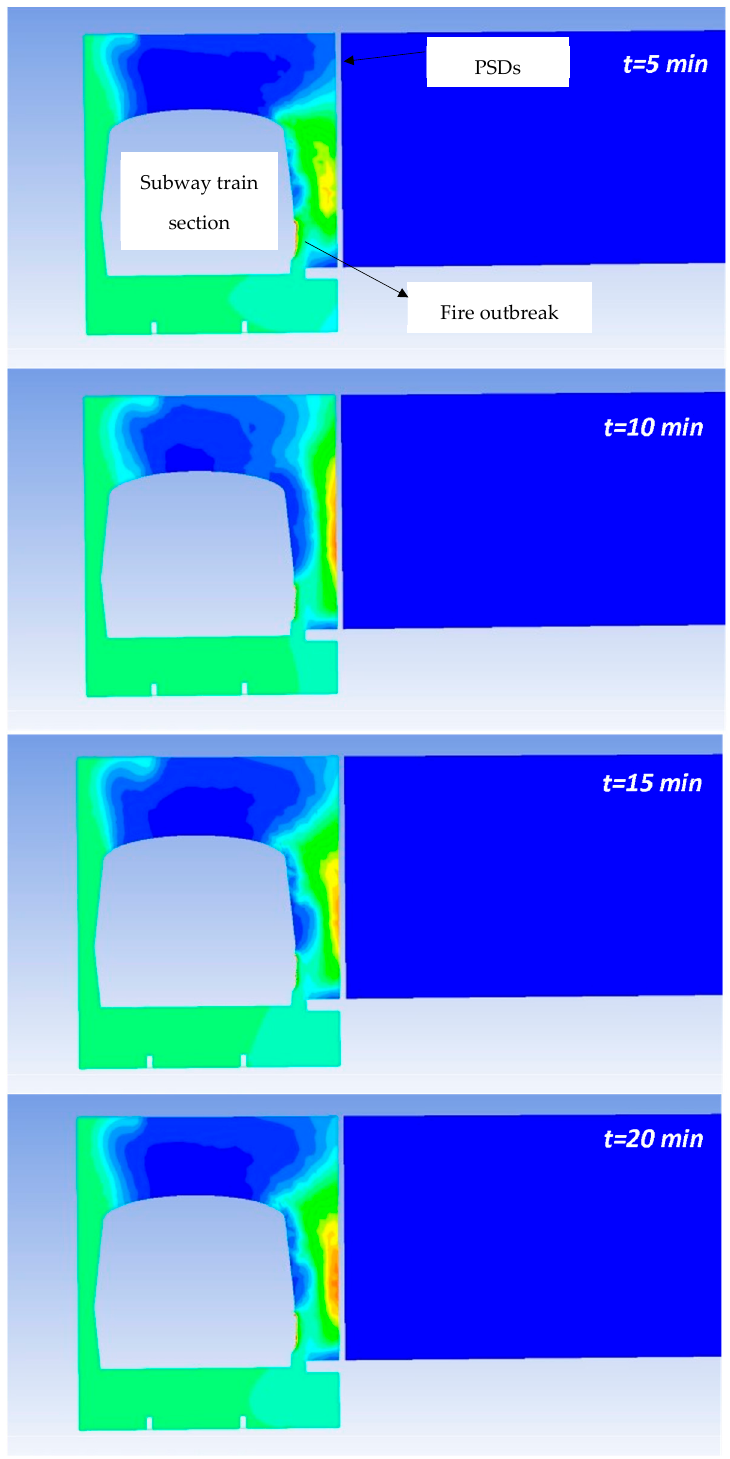
Figure 17. CO 2 contours (ppm)—cross section through the fire outbreak (minutes 5–20). Moreover, Figures 18–23 present the temperature, CO concentration, and CO 2 concen- tration through the door of the PSD system to the left of the fire outbreak; this is the place with the highest chance that the polluted hot air will enter the station.